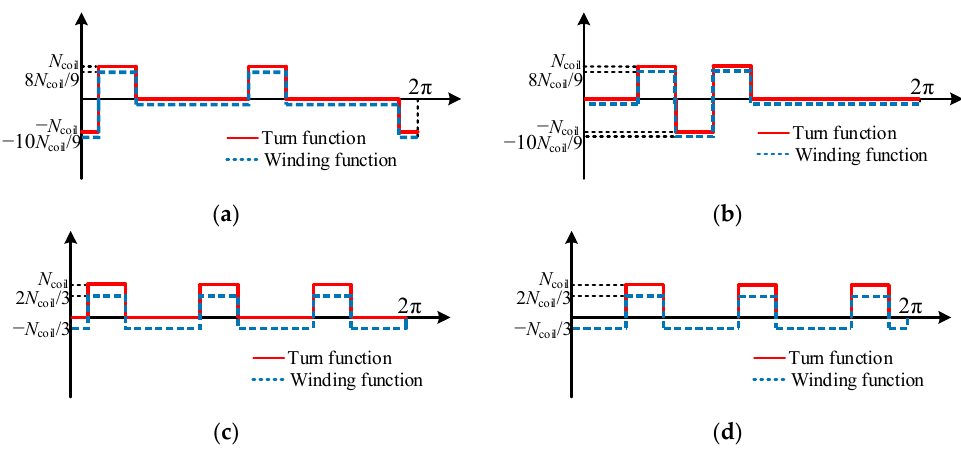
Figure 7. Turn and winding functions. ( a ) 8-pole mode/U-phase. ( b ) 8-pole mode/V-phase. ( c ) 24-pole mode/U-phase. ( d ) 24-pole mode/V-phase. Table 2. Calculated PM flux linkage and winding inductances.